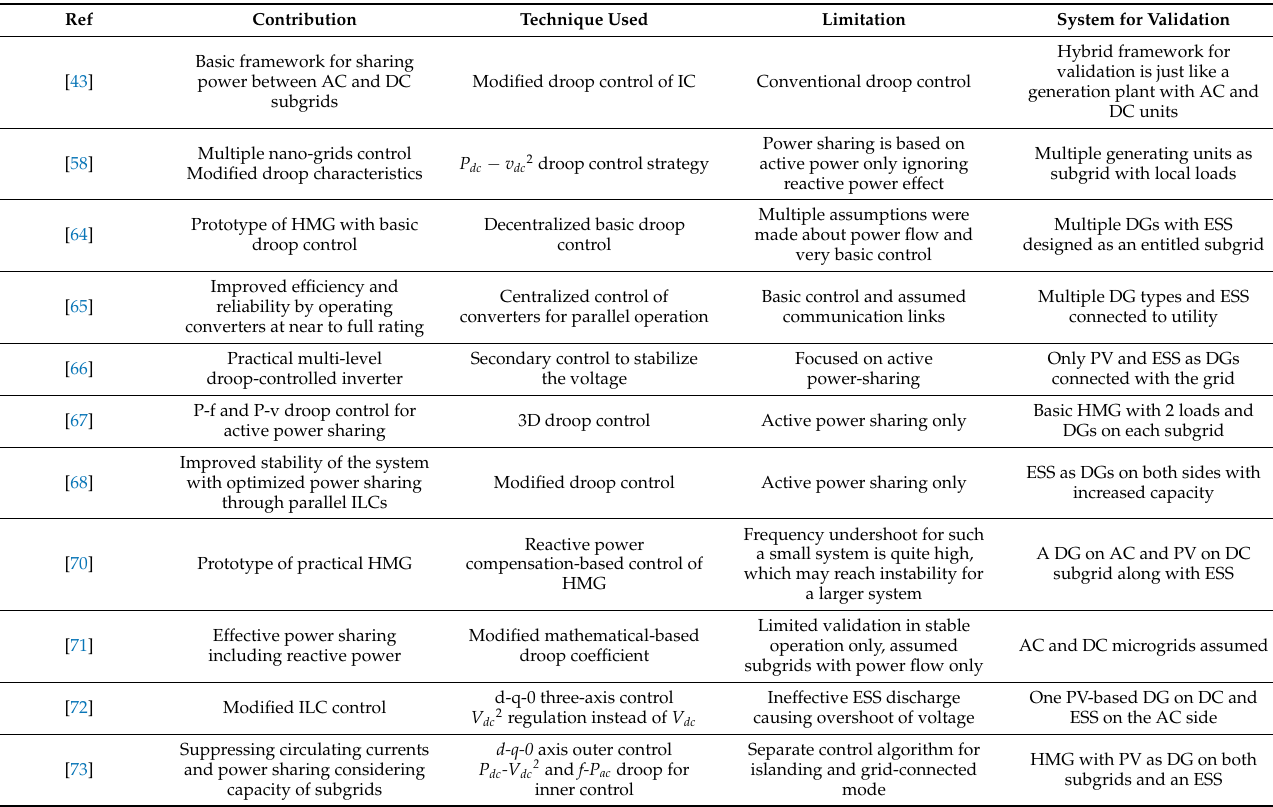
Table 3. Review table for power management of hybrid microgrid based on ILC